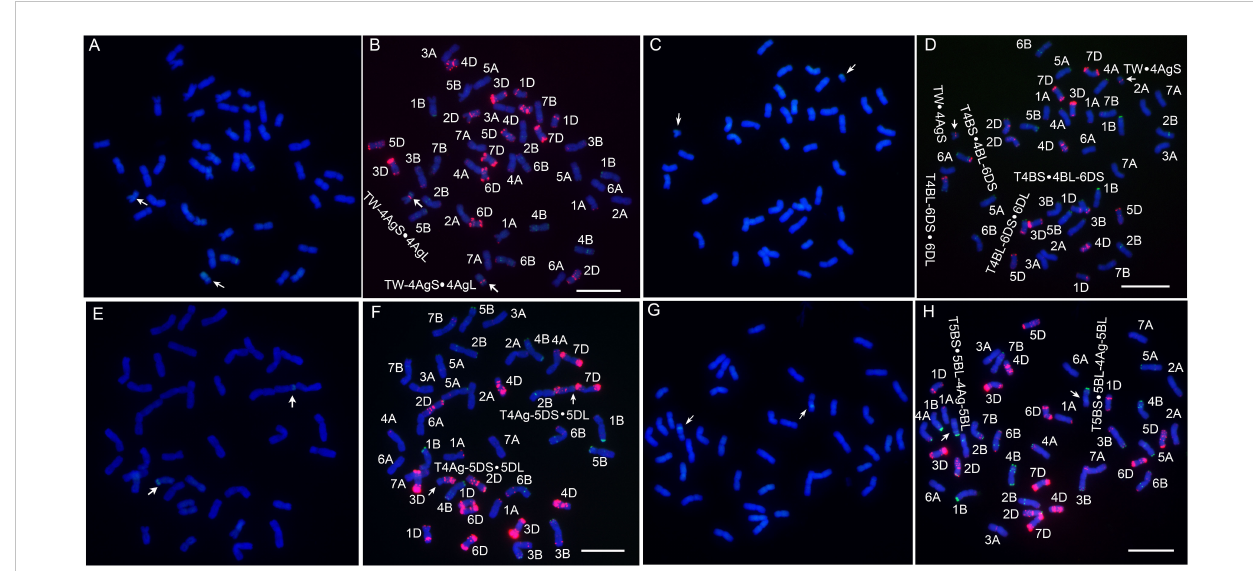
FIGURE 4 Sequential GISH and mc-FISH analysis of translocation lines. (A) The GISH pattern of L1 with total genomic DNA of Th. ponticum as a probe. (B) The mc-FISH pattern of L1 using two probes pAs1 (red) and pSc119.2 (green). (C) The GISH pattern of WTT139. (D) The mc-FISH pattern of WTT139. (E) The GISH pattern of WTT146. (F) The mc-FISH pattern of WTT146. (G) The GISH pattern of WTT323. (H) The mc-FISH pattern of WTT323. The arrows note a pair of translocated chromosomes. Bar = 20 m